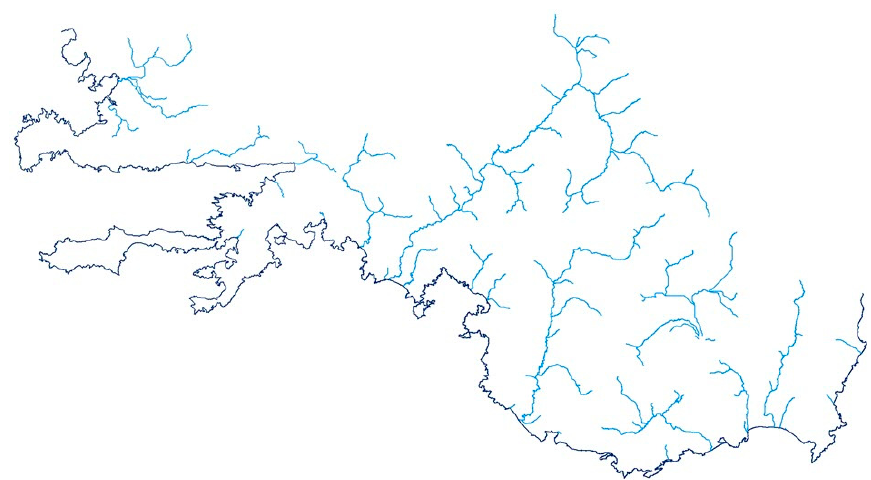
Figure 6. The drainage network derived according to the OnePercent value.